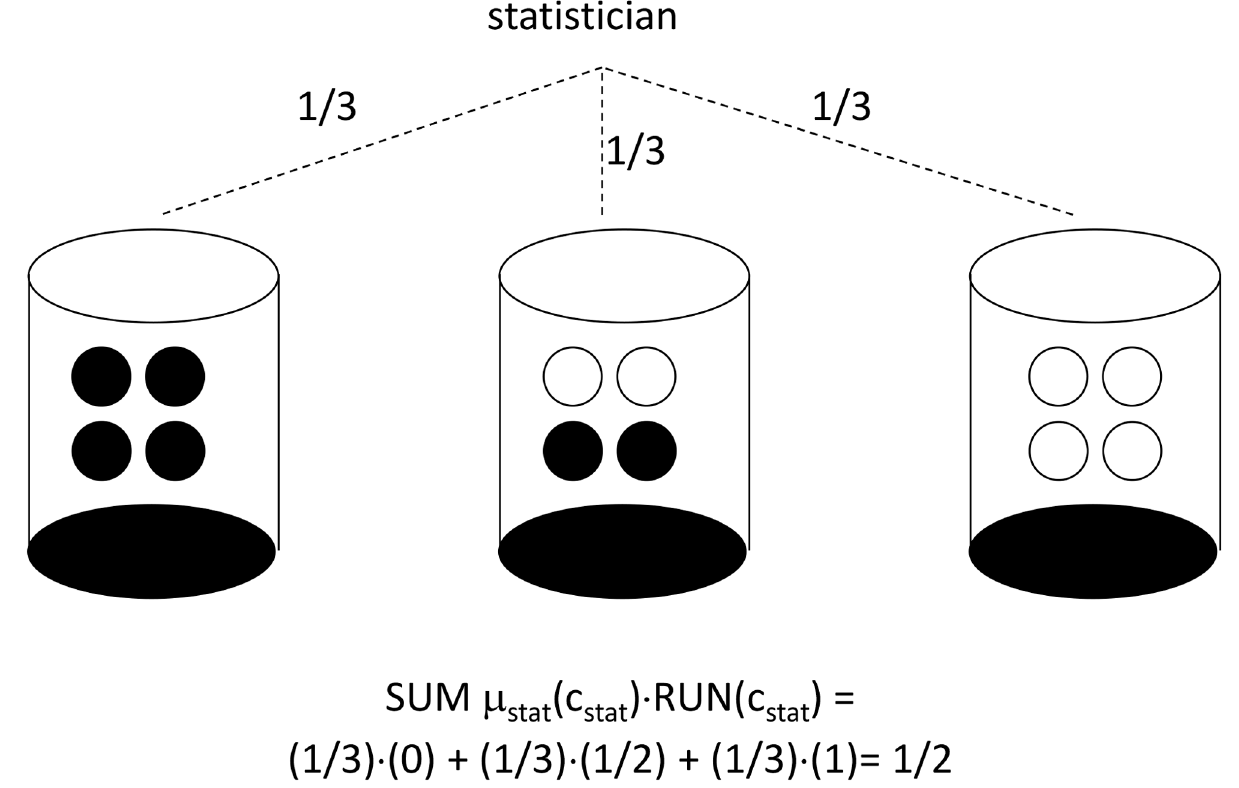
Fig 2. Urn Design for Run-Reversal Equilibrium with 4 Clinics. An urn is selected according to the probabilities shown, and then balls are drawn without replacement until the urn is empty. A run in treatment imbalance is assigned for a clinic when a white ball is drawn. A reversal in treatment imbalance is assigned for a clinic when a black ball is